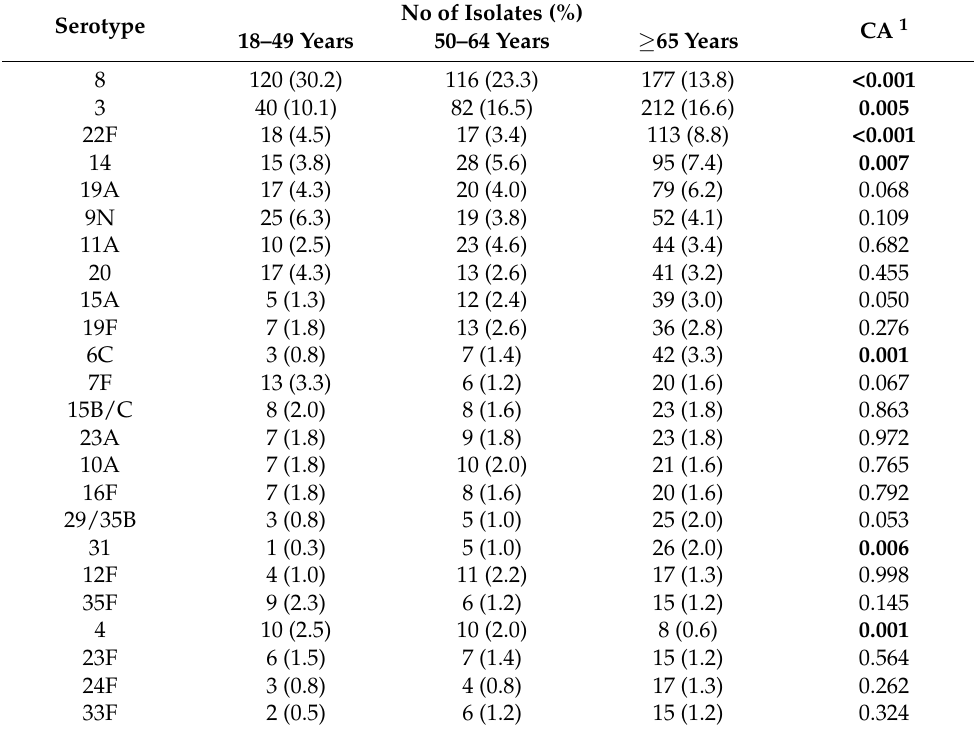
Table 1. Serotype distribution in each age group ( n > 20 isolates).